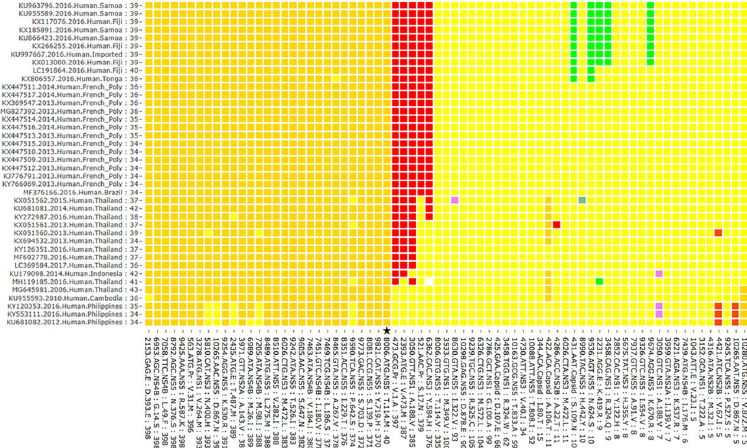
Fig 2. Overview of the dispersal patterns of nonsynonymous mutations within all sequences from Cluster 0. Subsection of the graph from Fig 1 showing higher resolution of mutation patterns within the Cluster 0. Cluster 0 is defined by NS5 mutation Thr114Met (marked by a star) first detected in 2006. Mutation accession numbers, year, host type, country and number of mutations detected in genomes are listed on the y axis. Genomes listed in the y axis are listed in order that best illustrates mutation clusters. Y-axis labels include: Accession number. year. species. geographic location the mutation was identified: total number of mutations identified in that genome compared to the reference genome (Malaysia